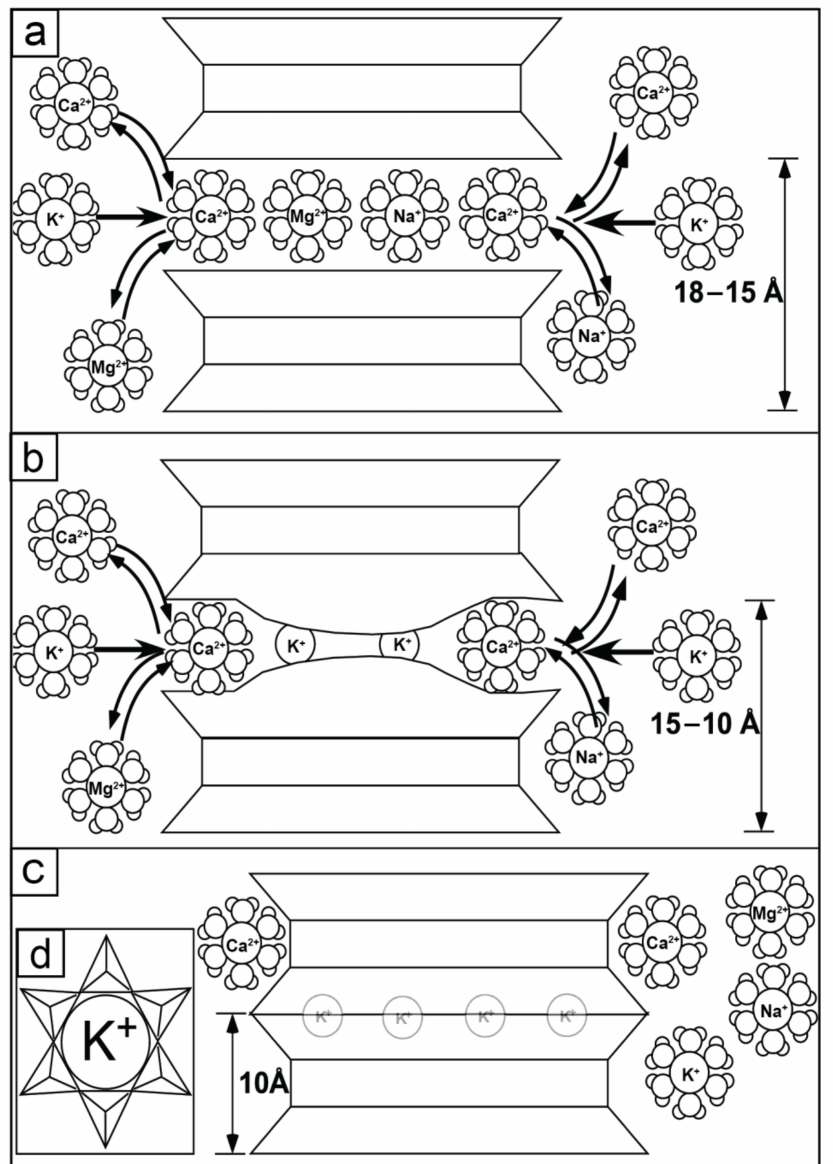
Figure 1. Model of the stages of smectite illitization. ( a ) A cross-sectional view of an expandable 2:1 phyllosilicate at the onset of illitization. Hydrous clay minerals, i.e., smectite, readily